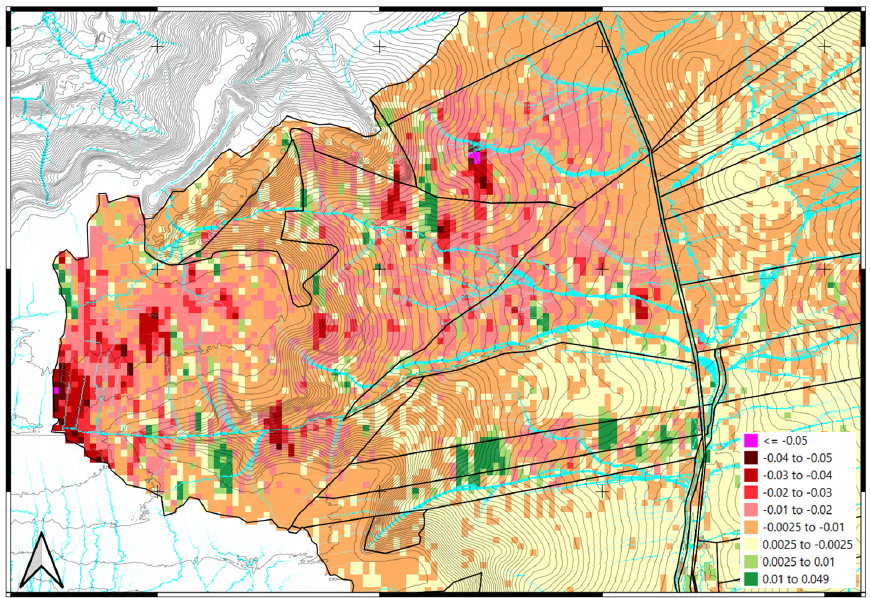
Figure 15. Detail of a plot in STM-2 with the combined effect of a previous tillage with the